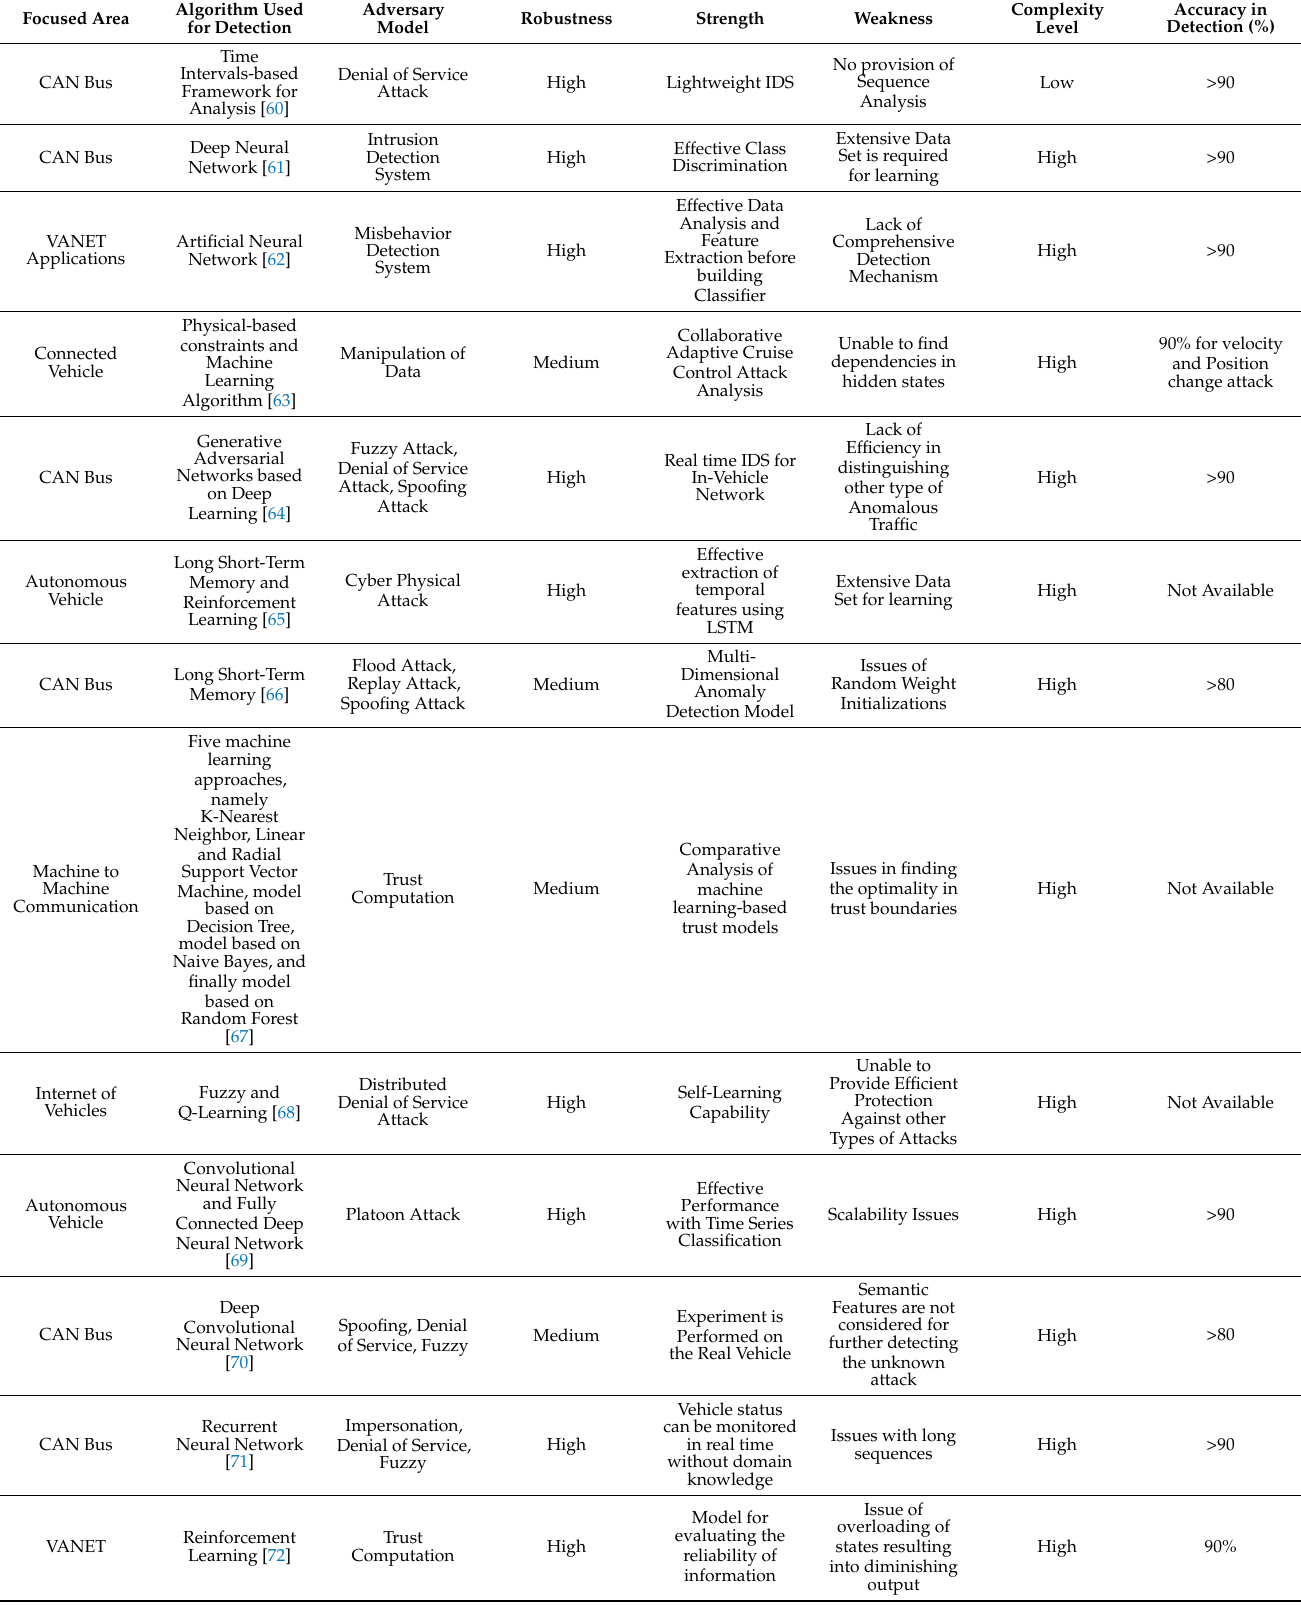
Table 2. Summary of characteristics of security solutions based on machine learning